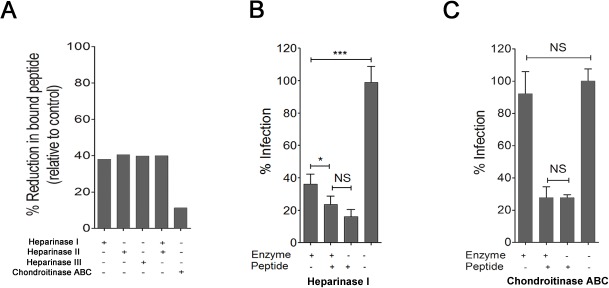
Peptide interacts with cell surface heparan sulfate but not chondroitin sulfate to mediate anti-viral activities.(A) MEF 10.1 cells were treated with heparinase I, II, III or chondroitinase ABC and the amount of bound peptide was assessed as described in materials and methods. (B) Cells were treated with heparinase I (1U/ml) or (C) chondroitinase ABC (1U/ml) and peptide p5+14 was added. The amount of plaque reduction of MCMV infection in each treatment was measured in a plaque reduction assay. Bars represent the average of the percent reduction in infection compared to PBS-treated control from three independent experiments with at least three replicates in each + SD. Statistical significance is indicated as: * = p<0.05, ** = p<0.01, *** = p<0.001, NS = non-significant difference in the reduction of infection.